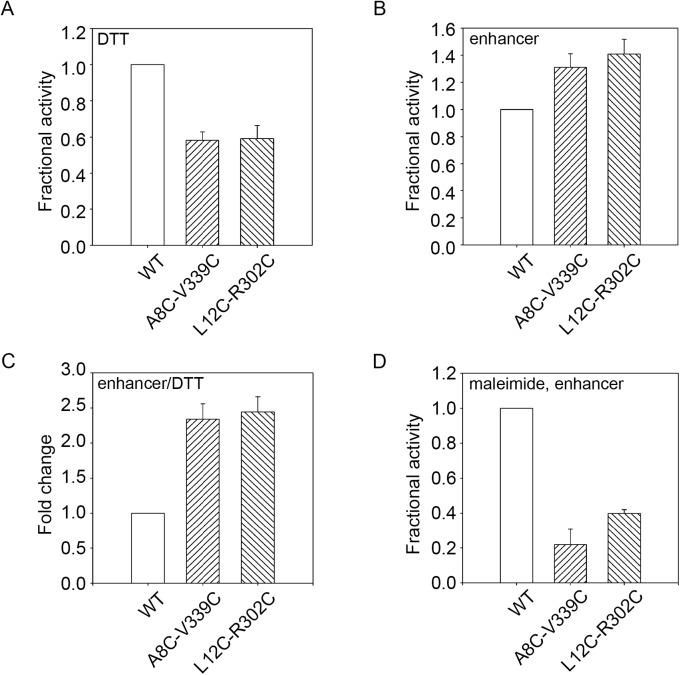
Disulfide stabilization under stringent biochemical conditions.The PrtS cysteine mutants were refolded and assessed functionally in reducing and oxidizing conditions and activity was assessed at pH 9.5 at 55°C. A, activity assays of the PrtS proteins refolded in the presence of DTT are shown and normalized to the activity observed with the wildtype protein. B, activity assays of the PrtS proteins refolded in the presence of a disulfide-enhancing additive are shown and normalized to the activity observed with the wildtype protein. C, the fold change between reducing and oxidizing conditions, A and B, is shown for the wildtype and mutant proteins. D, the PrtS protein were pre-incubated with maleimide and refolded as in C. Activity is shown normalized to the wildtype. Data shown are mean ± standard deviation from at least three independent experiments. Relative activity values were derived from the mean reaction velocities under steady state conditions with wildtype PrtS activity normalized to 1.0.